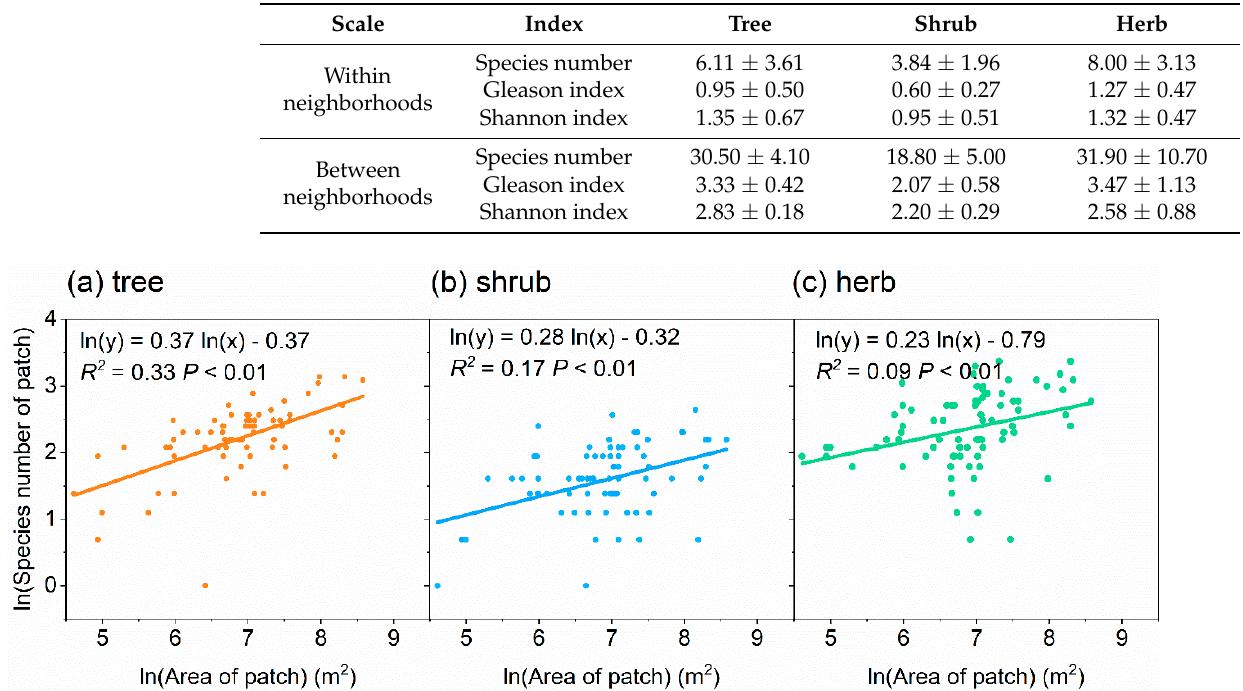
Figure 3. Relationships between patch area and number of species of the patch for trees ( a ), shrubs ( b ) and herbs ( c